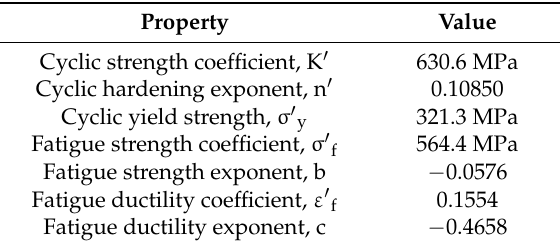
Table 3. Uniaxial properties of S355-J2G3 steel.